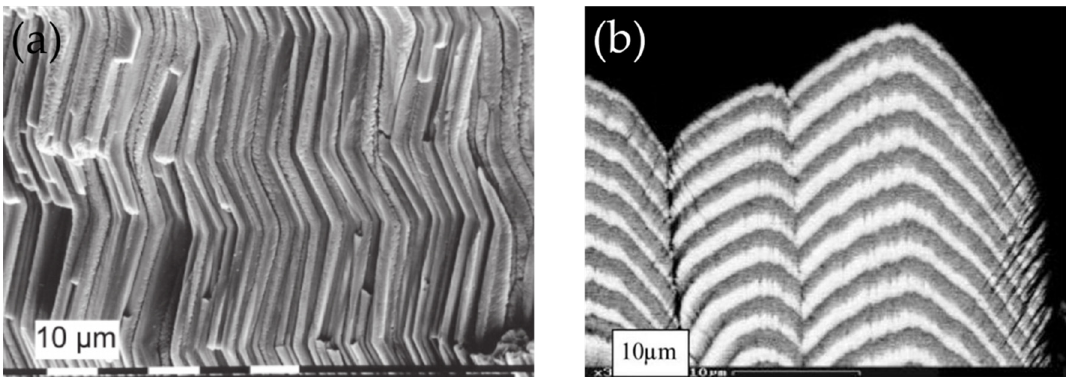
Figure 17 Figure 17. ( a ) Zig-zag structured (reproduced with permission from [82], John Wiley and Sons, 2005) and ( b ) multilayered EB-PVD TBC (reproduced with permission from [83], Elsevier,